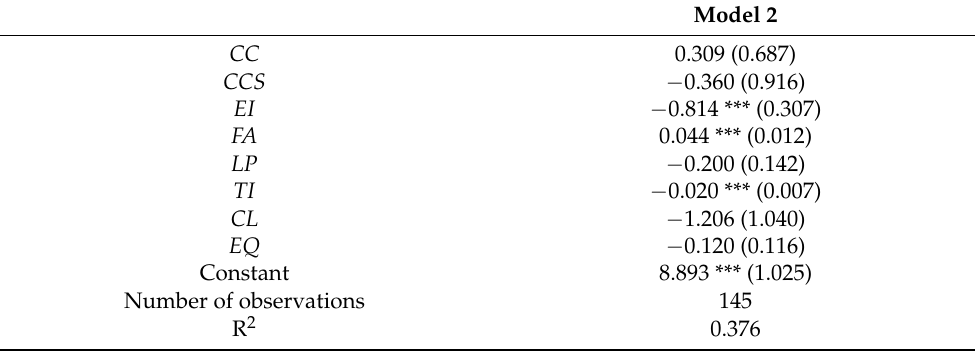
Table 4. Regression results of Model 2.